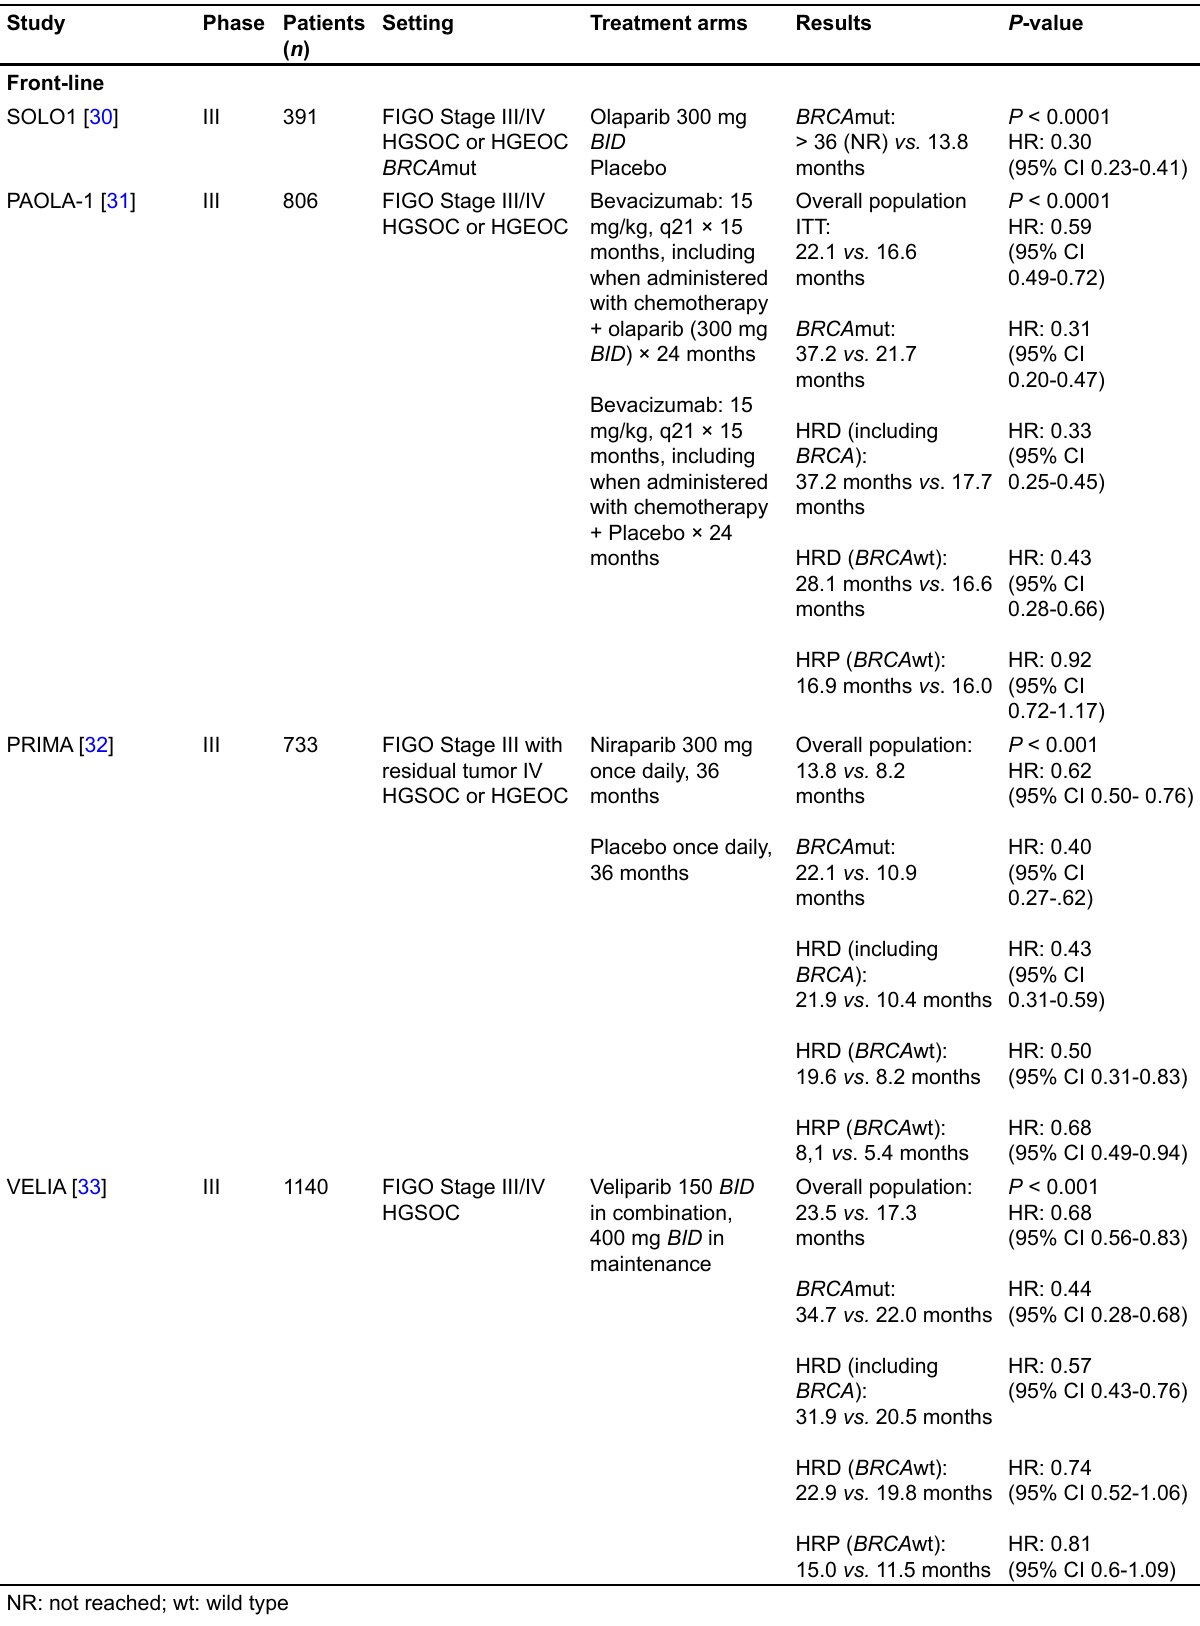
Table 1. Clinical trials results for PARP Inhibitors in ovarian cancer ( continued ) Study Phase Patients